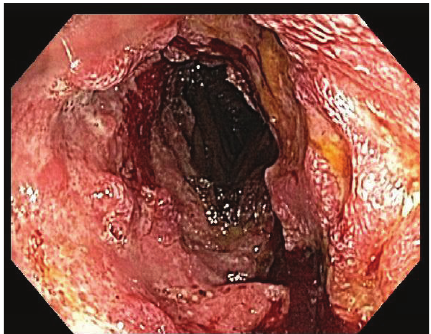
Figure 1: A push enteroscopy shows a 10cm long, friable, ulcerated mass in the 3rd part of the jejunum.